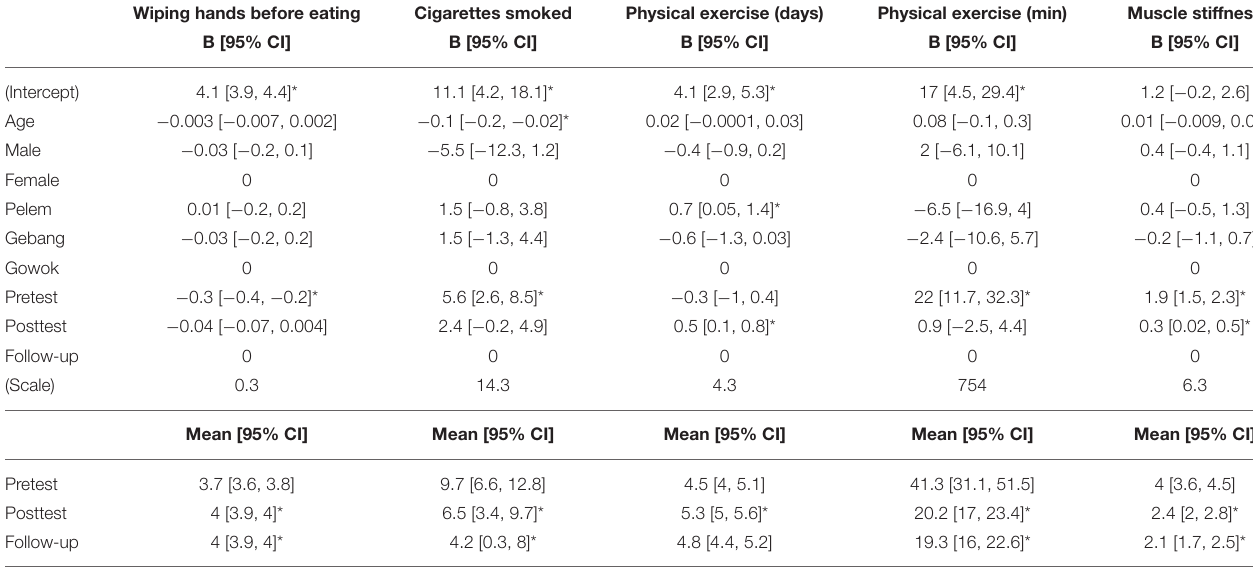
TABLE 3 | Regression coefficients and estimated marginal means of hand hygiene, cigarettes smoked, time spent on physical exercise, and muscle stiffness. Wiping hands before eating Cigarettes smoked Physical exercise (days) Physical exercise (min) Muscle